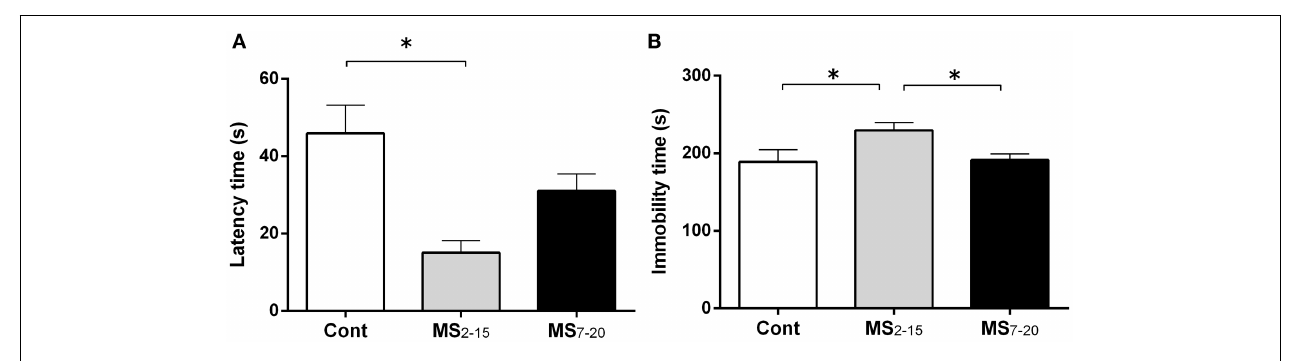
and MS 7–20 groups at 3months of age. Each bar represents the mean + SEM from 11 to 20 rats per group from one of two independent experiments.